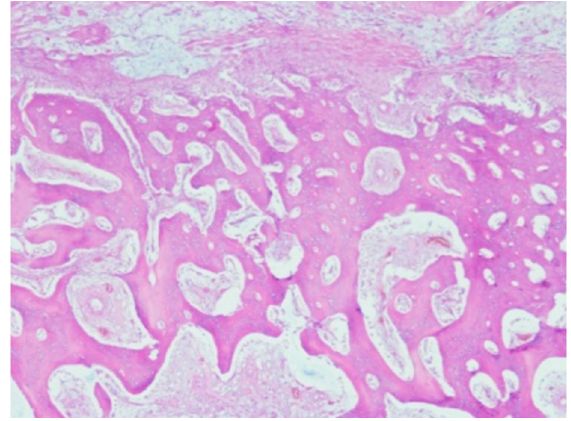
Figure 8. Fibrosis and maturing bone near the titanium